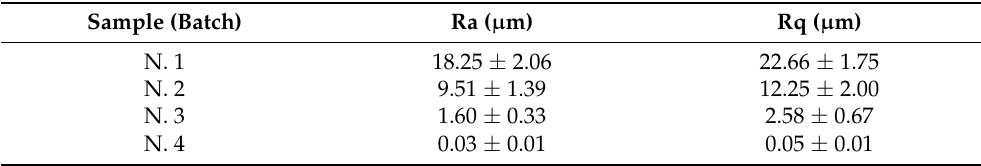
Table 3. Vertical surface roughness average (Ra) and root mean square roughness (Rq) of the sample